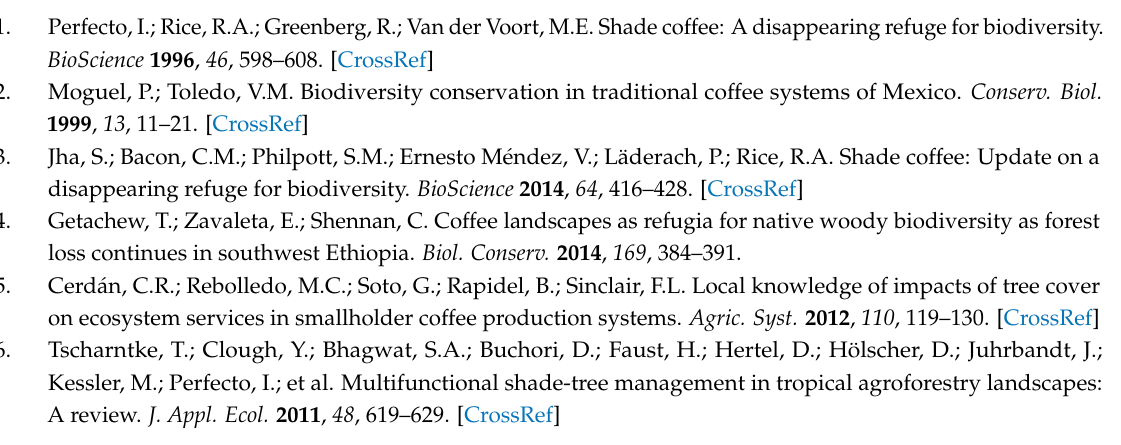
Table S1: Metadata for all utilized Landsat 8 images, Table S2: Kappa Index Values for the Multi-Seasonal Spectral Model ( S+TP ) with Different Specifications of mtry and N, and Table S3: Error Matrices for All Remaining RF Model